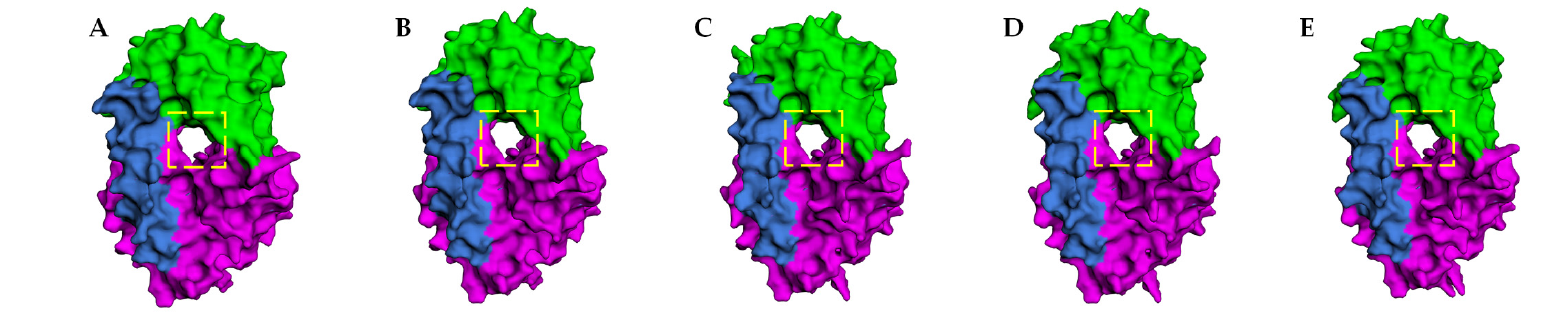
Figure 3. Structural comparison of Tet(X) proteins synthesized by Bacteroides fragilis ( A ), Epilithonimonas sp. FP105 and FP211-J200 and Chryseobacterium sp. SNU WT5 and SNUWT7 ( B ), C. sp. MOF25P and BGARF1B ( C ), strains Flavobacterium kayseriense F-47 and F-380 ( D ), and strain F. plurextorum CCUG 60,112 ( E ) strains isolated from fishes. The substrate-binding domain (light green), FAD-binding domain (pink), and C-terminal helix (blue) are displayed, while the open substrate-loading channel is marked by a yellow dotted box. Table 2. Similarity of nucleotide and amino acid sequences of Tet(X) synthesized by Flavobacteriaceae strains isolated from fishes and Tet(X) produced by Bacteroides fragilis (control). Strain Percentage of Nucleotide/Amino Acid Similarity * (%) Strain Control FP105 FP211-J200 SNU WT5 Control